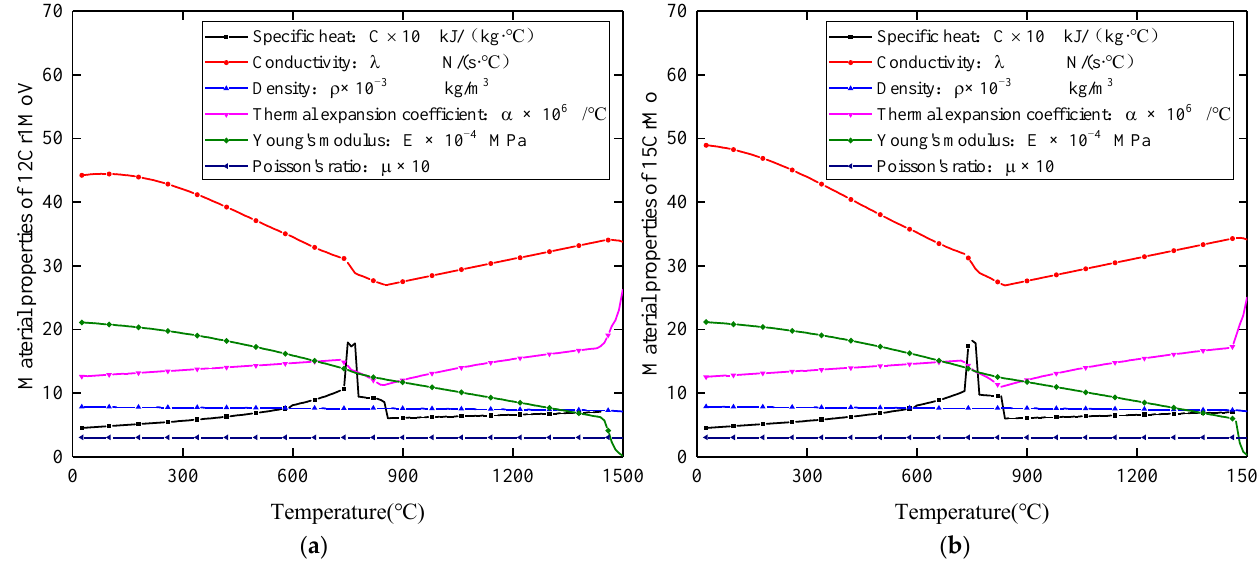
Figure 6. Temperature-dependent thermodynamic properties of ( a ) 12Cr1MoV steel and ( b ) 15CrMo steel. Table 2. Mechanical and thermal properties of weld metals.